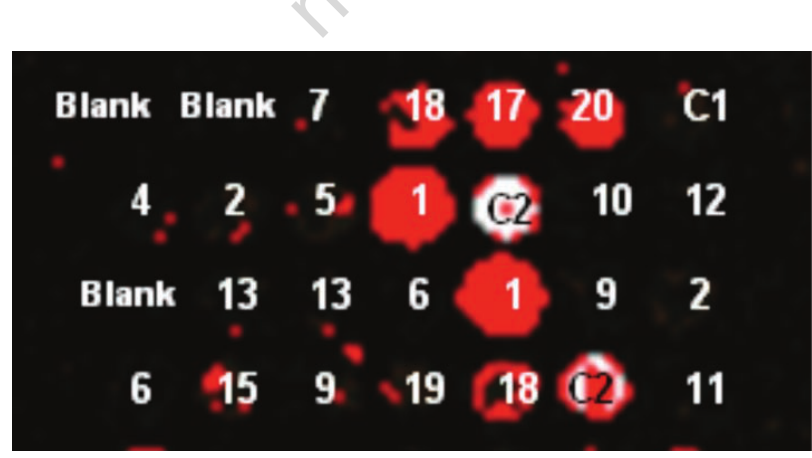
Figure 1. Partial fluorescent image of the DNA chip assay of the untreated water sample (probe concentration 250 ng/µL). Consult Table 1 for probe number